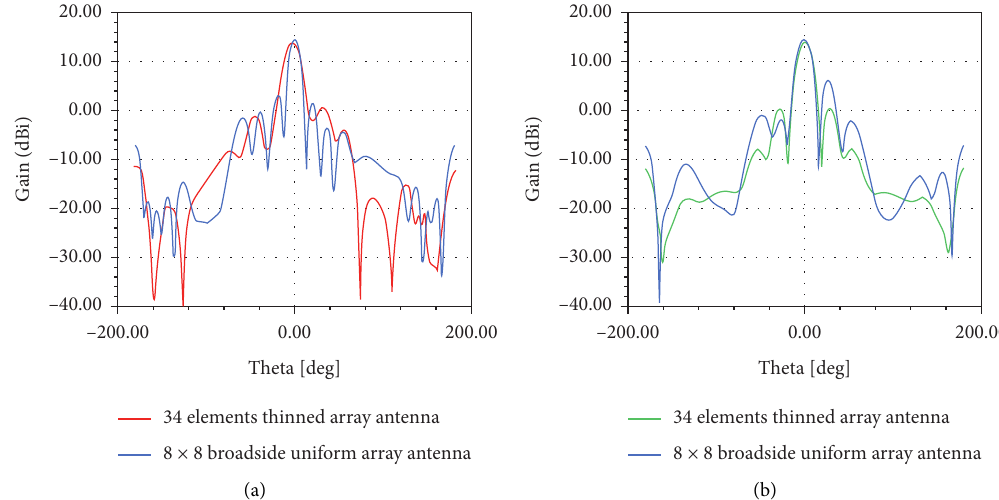
Figure 10: Comparison of radiation pattern between 34 elements thinned array antenna and 8 × 8 broadside uniform array antenna in E- plane (a) and H-plane